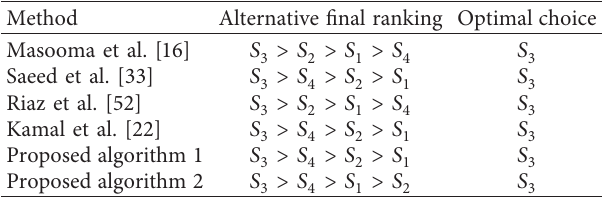
Table 9: Comparison between GmPNSS and some existing studies.